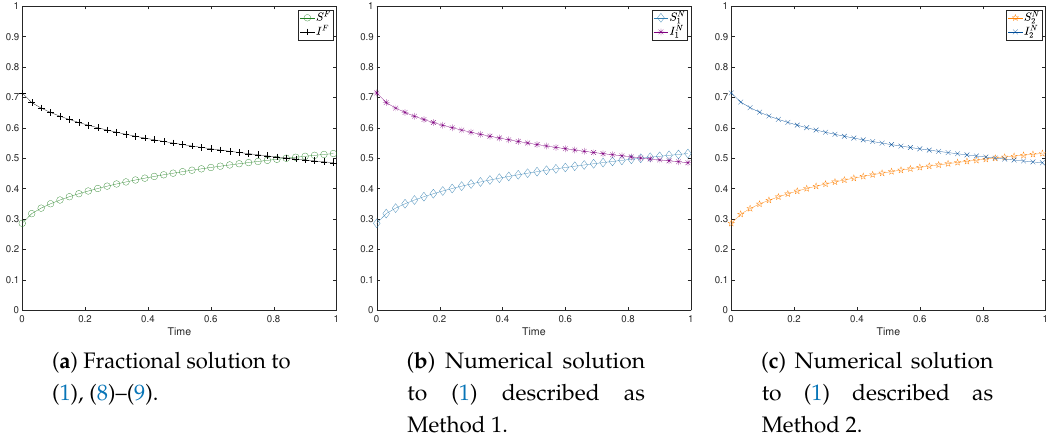
Figure 5. Comparison between the fractional solutions to (1) with α =